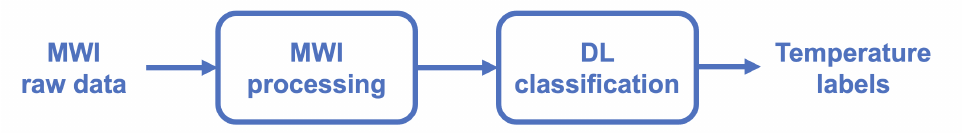
Figure 2. The basic ingredients of the proposed DL-MWI framework for temperature monitoring during HT